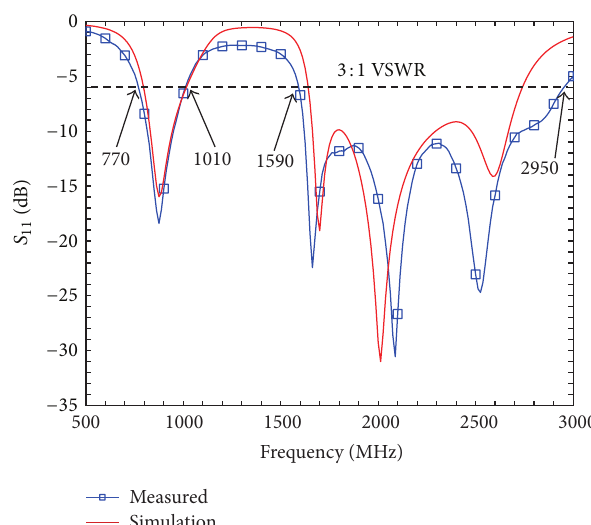
Figure 8: Measured and simulated 𝑆 11 of the proposed antenna.